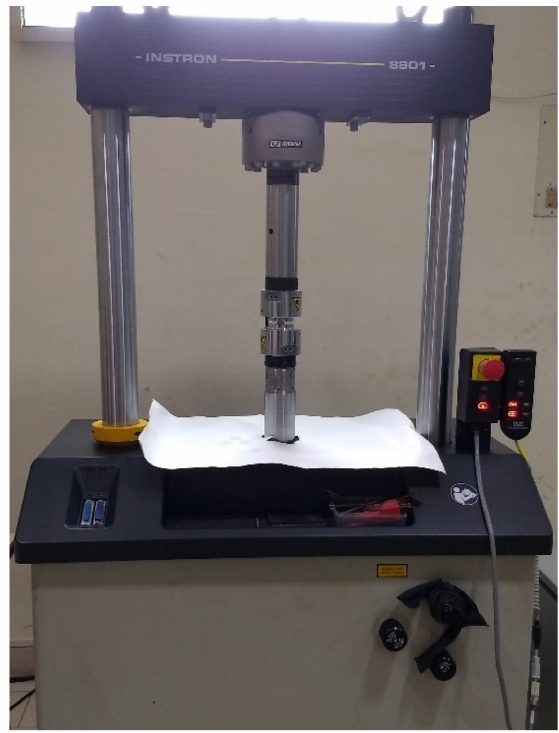
Figure 8. Instron 8801 UTM for tensile and bending test.